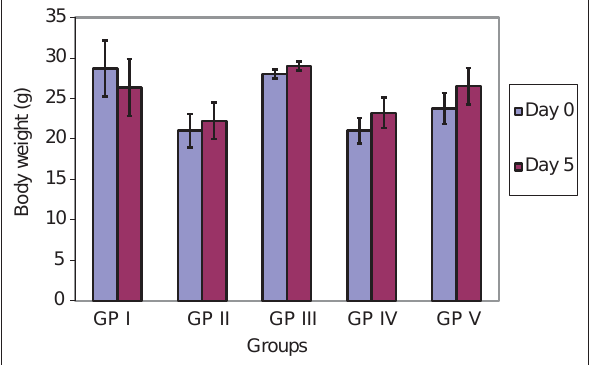
Figure-2: Effect of treatments with diminazene aceturate and ginger extract on the survival rate of mice experimentally infected with Trypanosoma brucei brucei . a,b Means with different superscript letters are statistically different (p<0.05). Values are mean ± standard error of the mean of 3 animals per group.